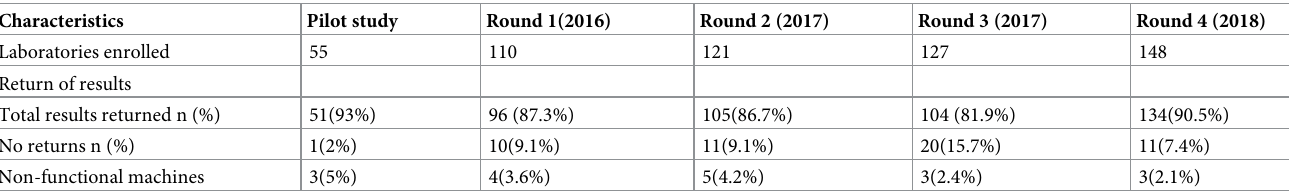
Table 1. Participation profile for all the rounds sent